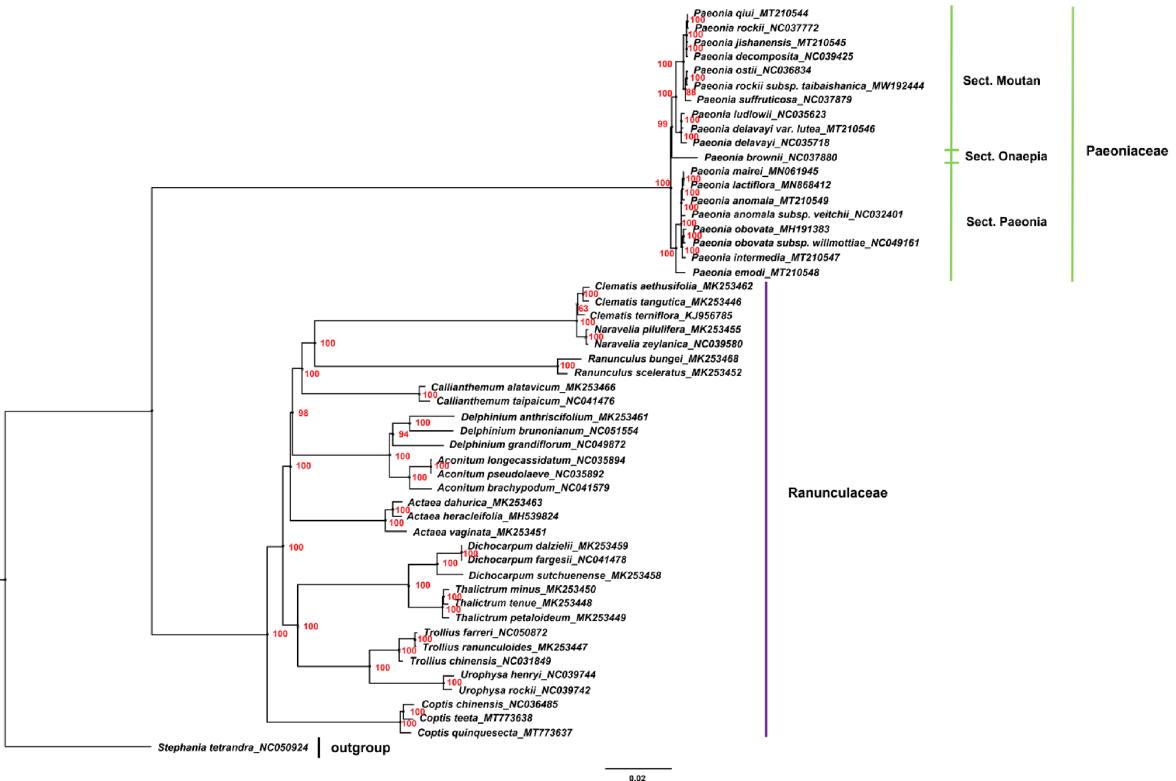
Figure 8. Phylogenetic tree constructed using Maximum Likelihood (ML) method based on the complete chloroplast genome sequences of 19 Paeoniaceae species and 32 Ranunculaceae species. Red numbers at nodes are values for bootstrap